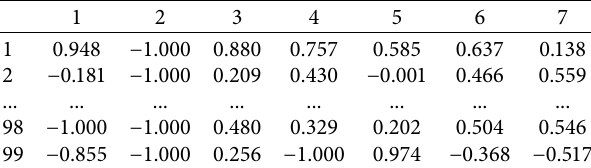
Table 1: Partial input values of training